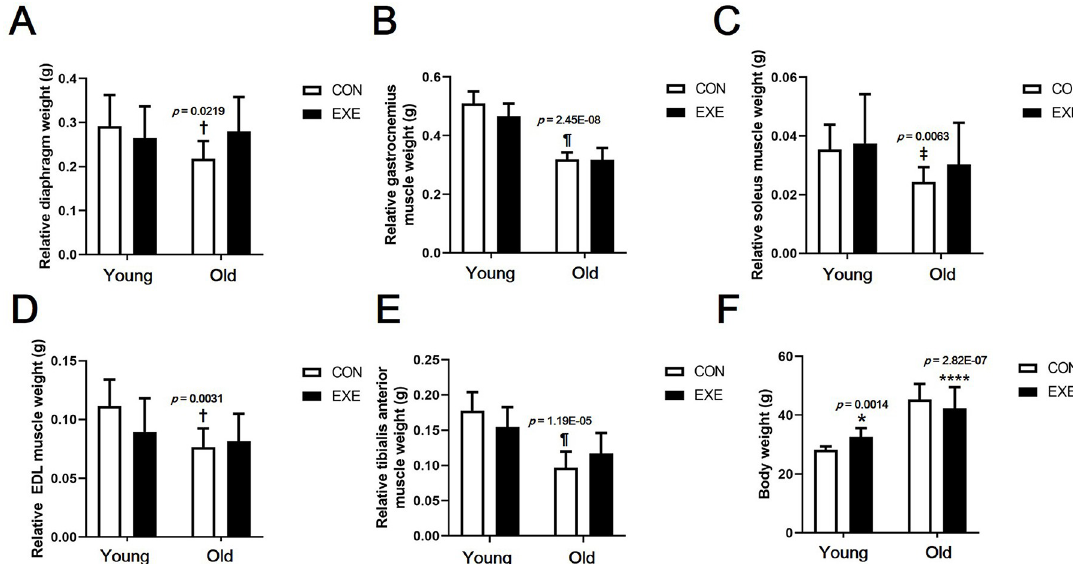
Fig 2. Difference in the mass of various skeletal muscles of experimental mice subjected to LSE. (A) Relative diaphragm weight. (B) Relative gastrocnemius muscle weight. (C) Relative soleus muscle weight. (D) Relative extensor digitorum longus muscle weight. (E) Relative tibialis anterior muscle weight. (F) Body weight. All data are presented as the mean ± SD vs. control group of same age, � p < 0.05 and ��� p < 0.001; vs. control group of different age, † p < 0.05, ‡ p < 0.01, and ¶ p < 0.0001.